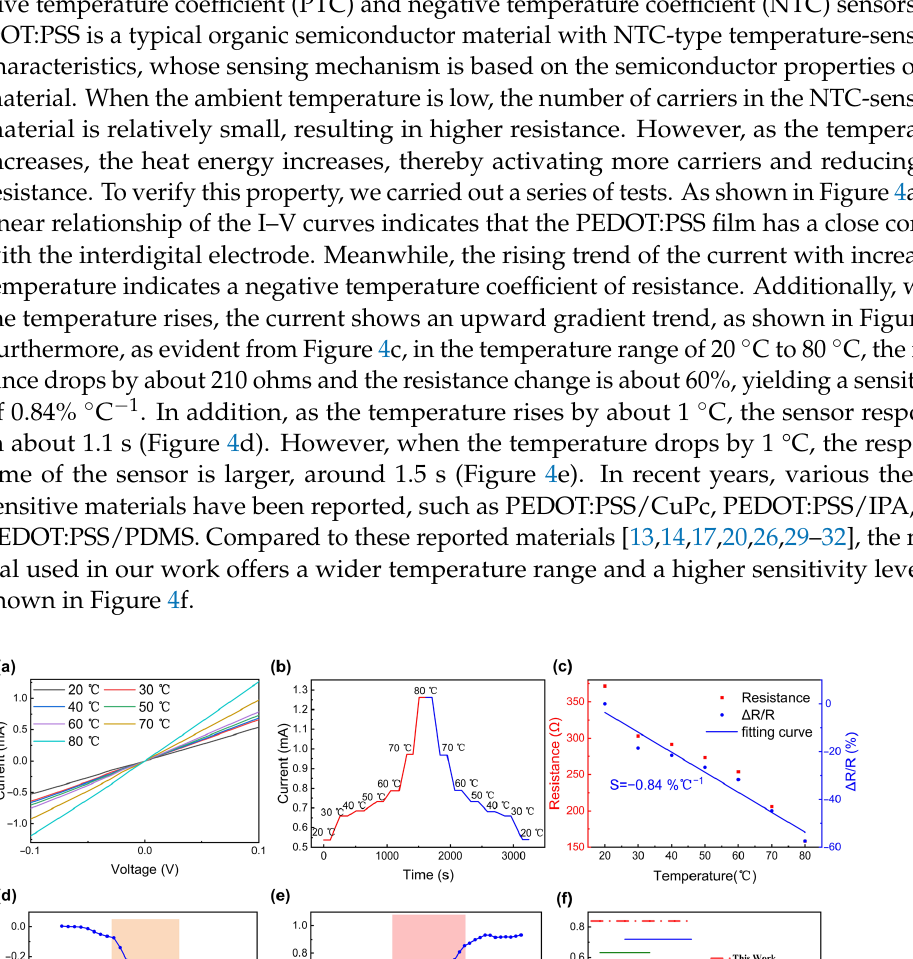
where, S (% °C −1 ) is the sensitivity; R 0 (Ω) is the initial resistance under 20 °C; R T (Ω) is the tested resistance when temperature changes; ΔT (°C) is the value of the temperature variation. 3.4. Sensing Performance of the Sensor when Pressure and Temperature Are Applied Simultaneously To verify the capability of the device to simultaneously handle both pressure and temperature stimuli, we used a digital source meter to detect the I-T curves in a temperature range of 20 °C to 80 °C at 0.8 kPa, and also in a pressure range of 0 kPa to 40 kPa at 30 °C. As shown in Figure 5a, the overall current change shows an increasing trend with the temperature, and the increase rate is small. However, a larger increase rate can be observed with the pressure, as shown in Figure 5b. This is because of the difference in thermal resistance and piezoresistive mechanisms [33], which have different degrees of influence on the resistance. Likewise, the same trend is also reflected in the sensitivity curves. As indicated in Figure 5c,d, the pressure and temperature sensitivity curves both tend to decrease, where the temperature sensitivity curves drop with a faster rate. The reason behind this could be as follows. As shown in Figures 3b and 4a, the device